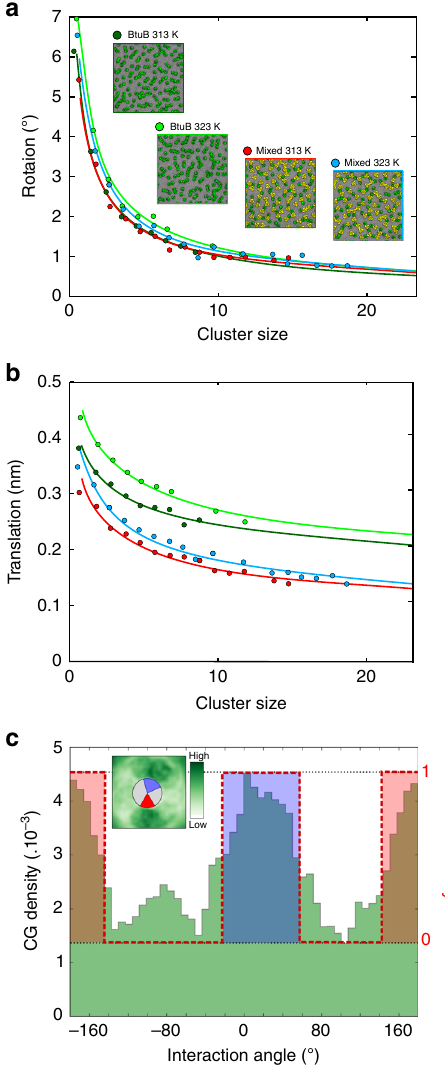
Fig. 5 Analysis of CG – MD simulations and parameterisation of the mesoscale model. Standard deviation of the distributions of BtuB molecular rotations ( a ) and translation ( b ) as functions of cluster size for the four BtuB-containing simulations. Rotations and translations were collected for the duration of each simulation over the time interval of 10 ns, and were found to be distributed normally, with mean zero. The lines correspond to fi tted power law functions used to parameterise the corresponding mesoscale models (see Supplementary Table 1 for details). c Frequency of occurrence (expressed as a density; see inset) of a neighbouring interacting BtuB molecule as a function of angle around a central BtuB molecule (from simulation BtuB313; also see Supplementary Figure 8). The two main peaks in the distribution, from − 10° to 55° (blue) and from 155° to − 155° (red), were used to de fi ne sticky patches of interaction between adjacent BtuB molecules in a mesoscale model (see main text for measured translational and rotational motions of OMPs as a function of cluster size in the CG – MD simulations (see Fig. 5a, b). Both translation (in the bilayer plane) and rotation (about the centre of mass of each cluster, in the plane of the bilayer; both over a period of e.g. 10 ns) depend strongly on cluster size. To extrapolate to the larger clusters which we anticipate in the mesoscale simulation sizes, we fi tted observed RMS rotation or translation vs. cluster size data using a power law function (see Supplementary Table 1 for further details).